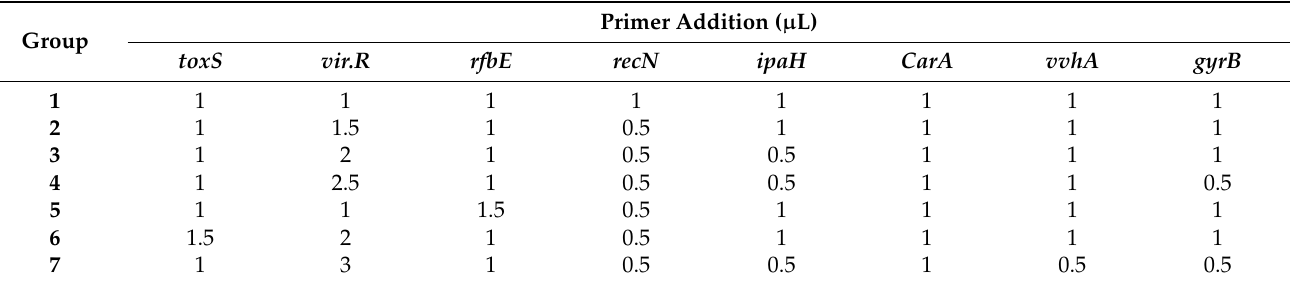
Table 4. Seven groups of primer